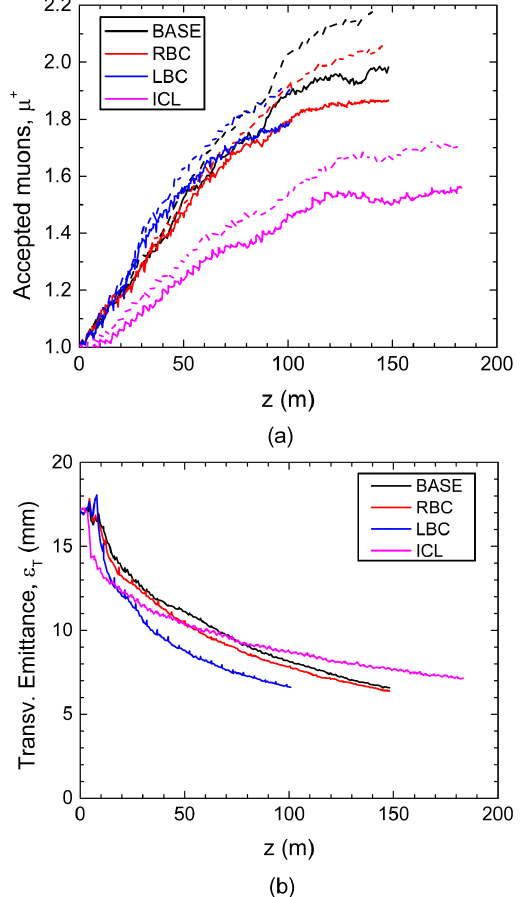
FIG. 10. ICOOL simulation results of the cooling performance as a function of distance along the channel: (a) The accepted muon yield within a transverse acceptance of A longitudinal acceptance of A L ≤ 15 0 mm. (b) Normalized trans- verse rms emittance. In (a) the dashed lines are with muon decay off and solid lines are with decay on.